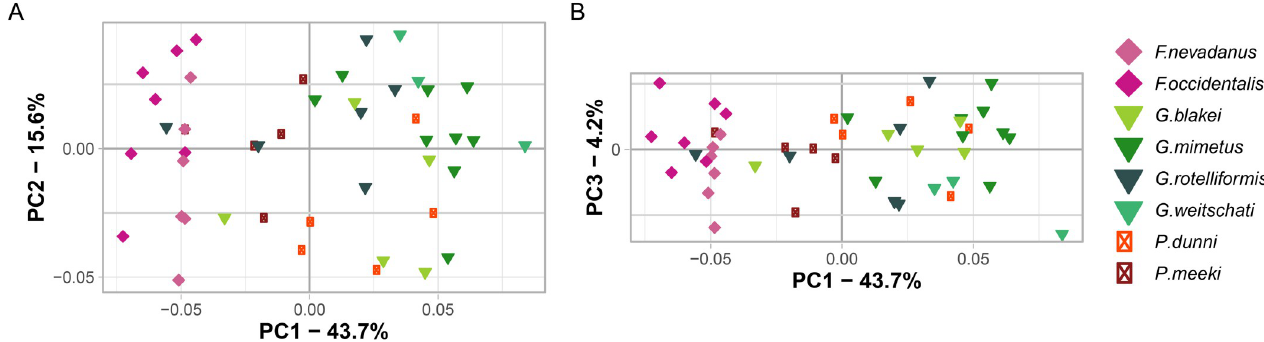
Fig 3. PCA plots of ontogenetic trajectory space of all species of (A) Principal Component 1 and 2; (B) Principal component 1 and 3.